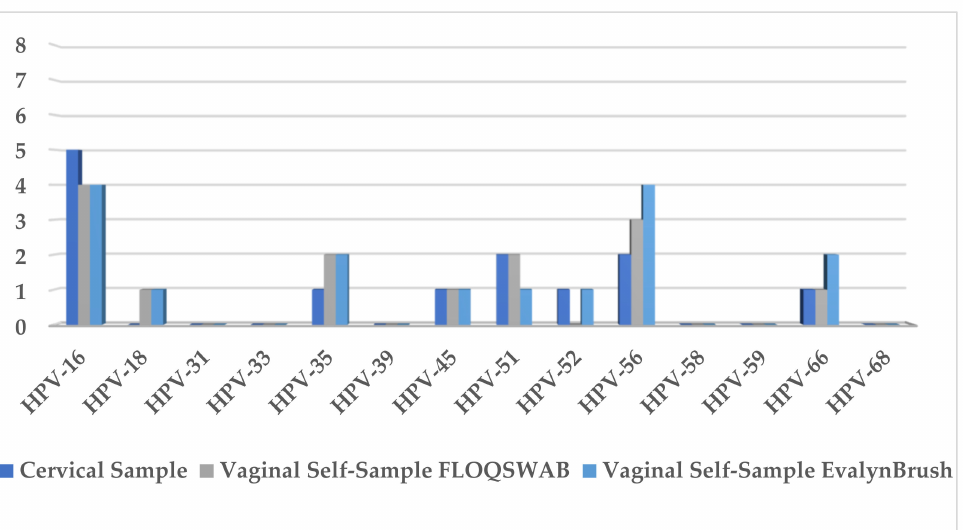
Figure 2. Prevalence of hrHPV genotypes from cervical samples and vaginal self-samples collected using FLOQSwabs ® (FS) and HerSwab™ (HS).